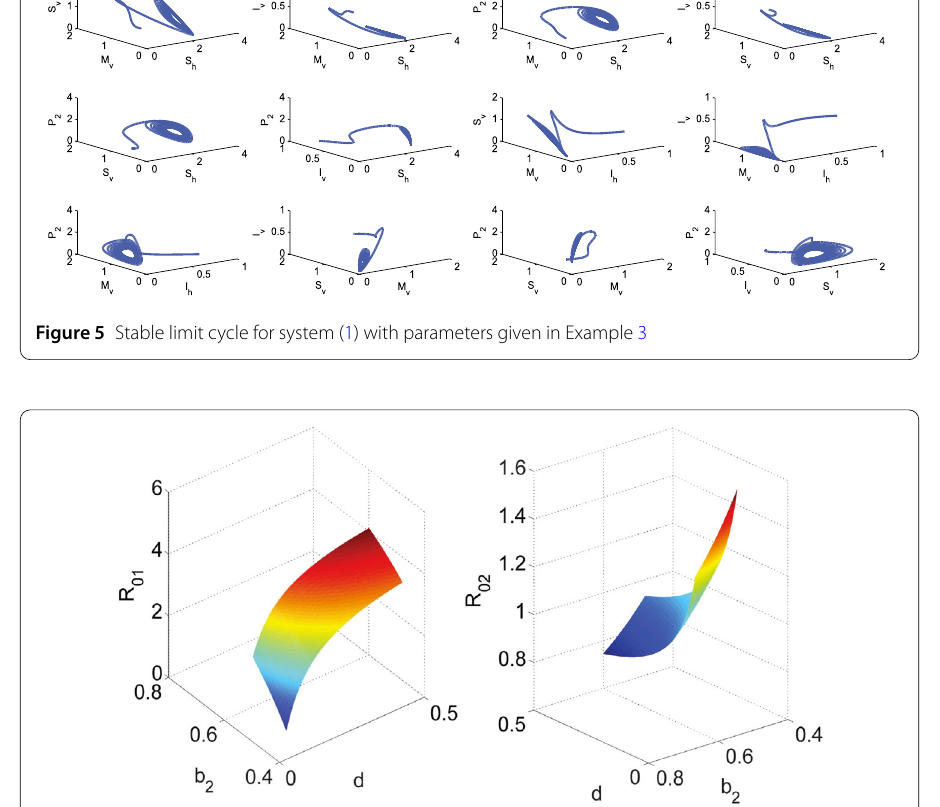
Figure 6 Surface plot of the basic reproduction numbers R 01 and R 02 as functions of b 2 and d for the parameters given in Example